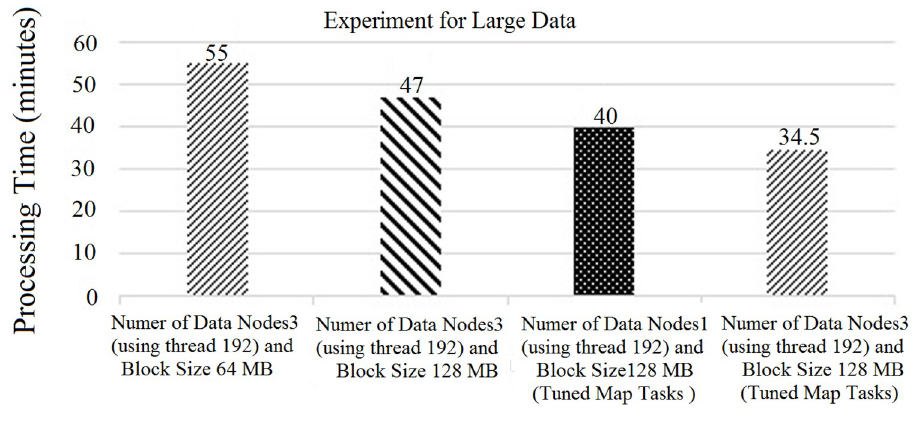
Fig 25. Experiment with tuned map tasks using single